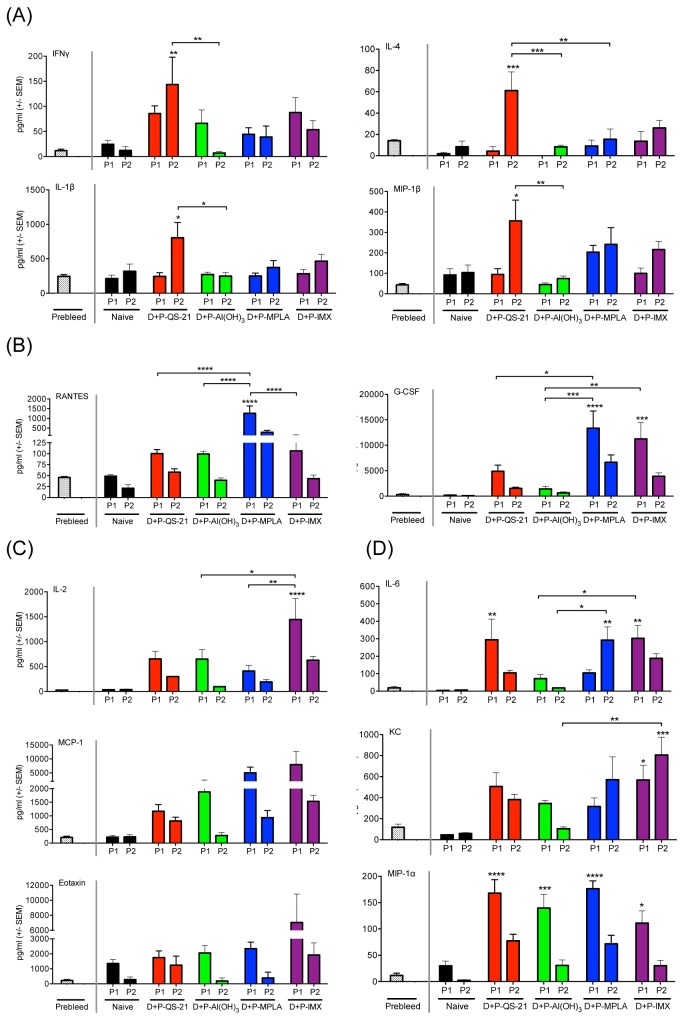
Serum cytokine concentration in mice vaccinated with DP6-001 and candidate adjuvants.C57Bl/6 wild type mice were immunized with DP6-001 DNA prime-protein boost (‘D+P’), with each protein boost formulated with QS-21 (D+P-QS-21), Al(OH)3 (D+P–Al(OH)3), MPLA (D+P-MPLA) or ISCOMATRIX™ adjuvant (D+P-IMX). Naïve mice received saline injections in lieu of immunization. Sera were collected pre-immunization and 6 hours following the first (P1) and second (P2) protein-adjuvant boosts. Cytokines were quantified in the serum of individual mice at a 1:4 dilution using a custom 12-plex Luminex panel. (A) QS-21 cytokine profile. (B) MPLA cytokine profile. (C) ISCOMATRIX™ adjuvant (IMX) cytokine profile. (D) Serum cytokines elevated following protein boost with formulations containing all candidate adjuvants. Significance over background is represented above error bars. Bracketed lines represent differences between adjuvant groups. Statistical significance was determined with a One-way ANOVA and Tukey post-test (*: p < .05, **: p < .01, ***: p < .001).